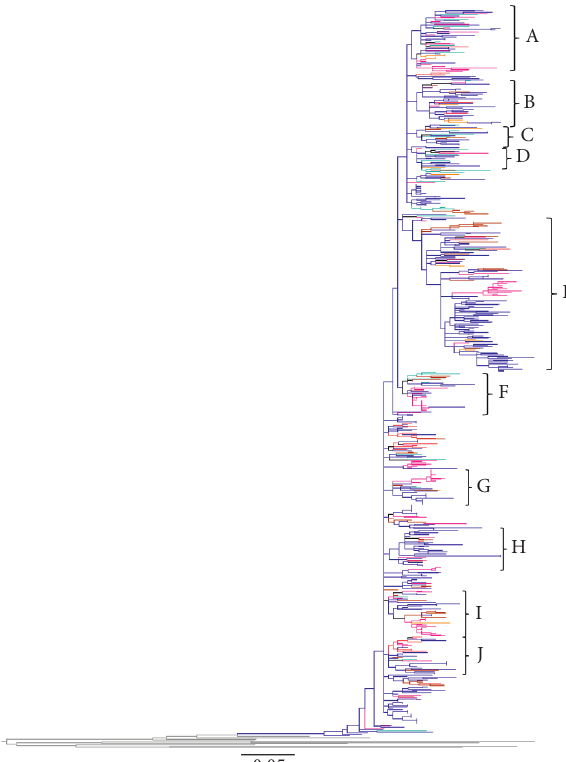
Figure 1: Phylogenetic relationship of HCV genotype 1b NS5B sequences from FSU countries: For the construction of the phy- logenetic tree, a stretch of HCV sequence corresponding to H77 nucleotide 8322–8555 was used. The sequences are included from Azerbaijan, Georgia, Estonia, Lithuania, Russia, Tajikistan, and Uzbekistan, represented by, respectively, orange, purple, pink, brown, dark blue, coral, and turquoise branches. The branches coded grey represent 10 outgroup reference sequences that were used to root the tree.